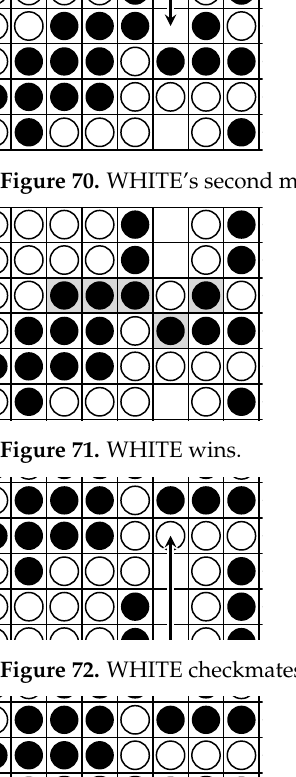
Figure 73. BLACK captures it.